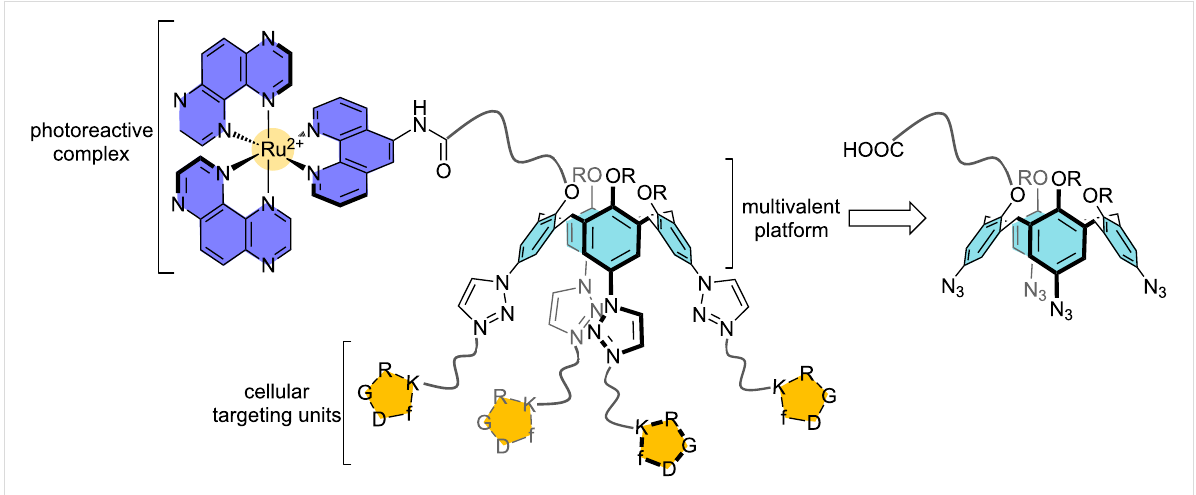
Figure 1: Targeted multivalent phototherapeutic agent and its calix[4]arene-based precursor. RGD = Arg–Gly–Asp residues, f = D-Phe